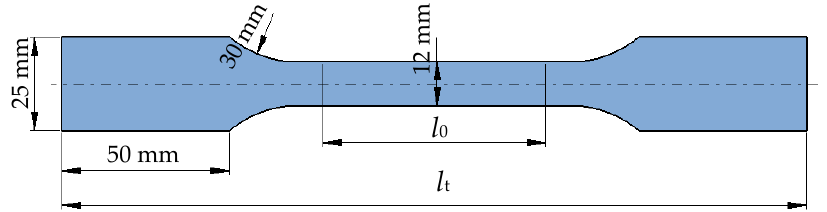
Figure 13. Tensile specimen. Table 3. Dimensions of each pass tensile specimen (mm).